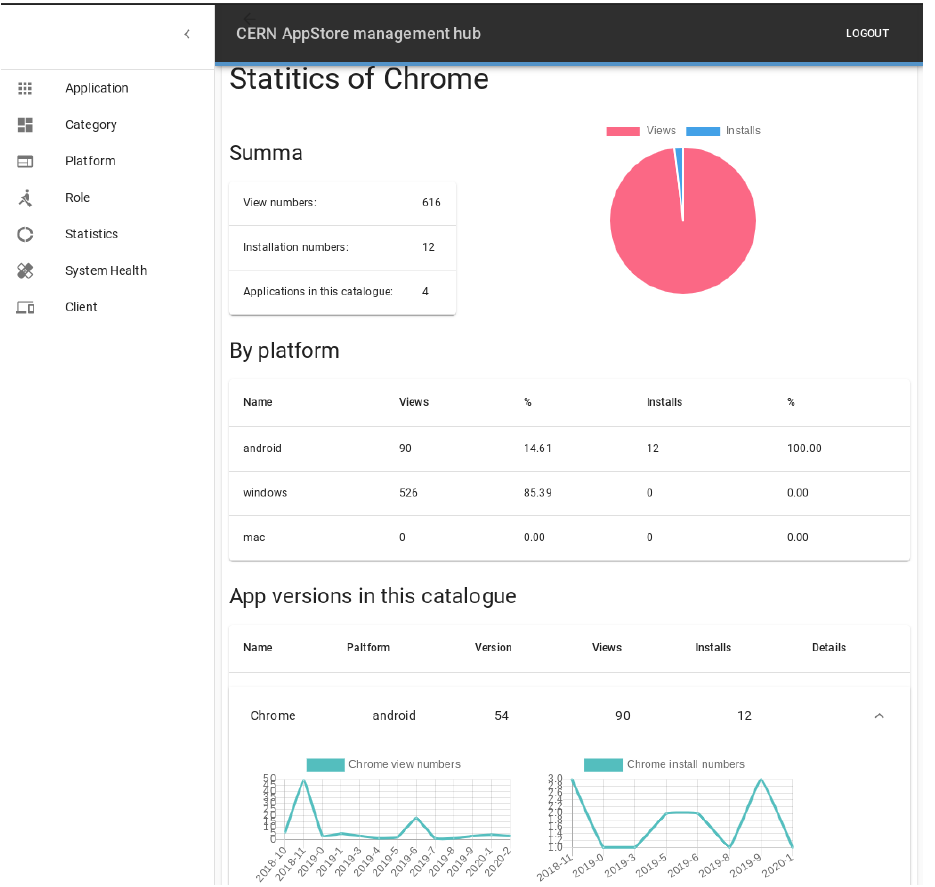
Figure 4. Management interface, showing Chrome usage